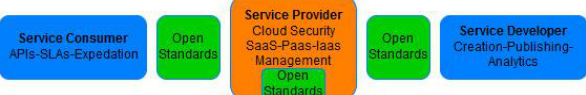
Figure 4. Architecture of BVRS (Du et al.,